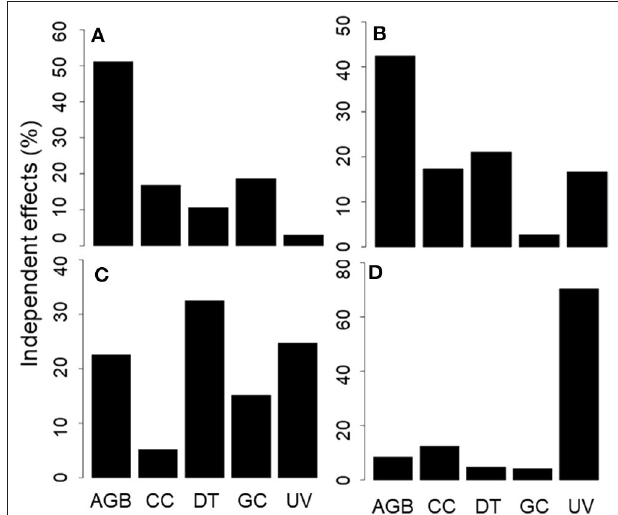
FIGURE 4 | Hierarchical partitioning graphs, showing the independent effect (in terms of percentage) of each vegetation structure variable on the likelihood of predation occurring for (A) artificial nests; (B) artificial seeds; (C) caterpillar models; and (D) frog models. Scales differ between each graph. AGB, aboveground biomass; CC, canopy cover; DT, dead trees; GC, ground cover; and UV, understorey